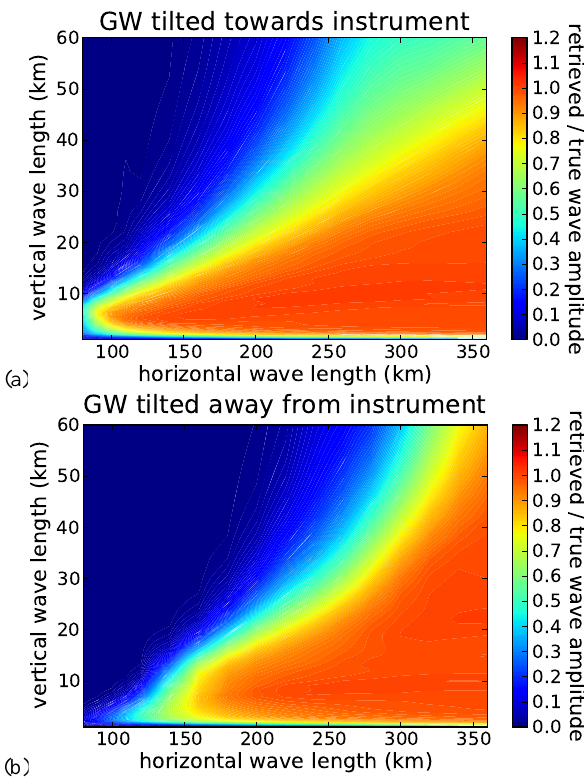
Fig. 12. The gravity wave filter as deduced from the averaging ker- nel. Each rectangle represents the mapping of a wave onto itself. (a) shows the diagonal elements for waves tilted towards the instru- ment (see also Fig. 9a), (b) shows the diagonal elements for waves tilted away from the instrument (see also Fig.